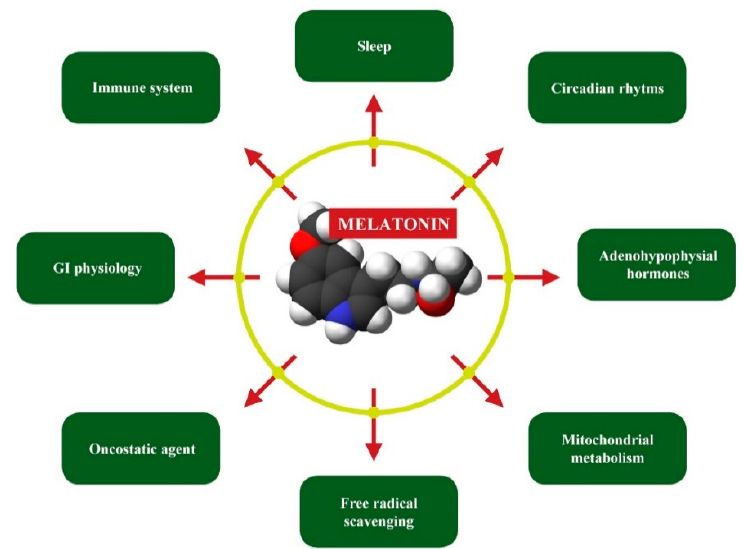
Figure 6. Most important physiological actions of melatonin. Reducing the level of melatonin, F (in yellowgreen) interferes with all indicated events. Image used from Wikimedia Commons according to GNU Free Documentation License.